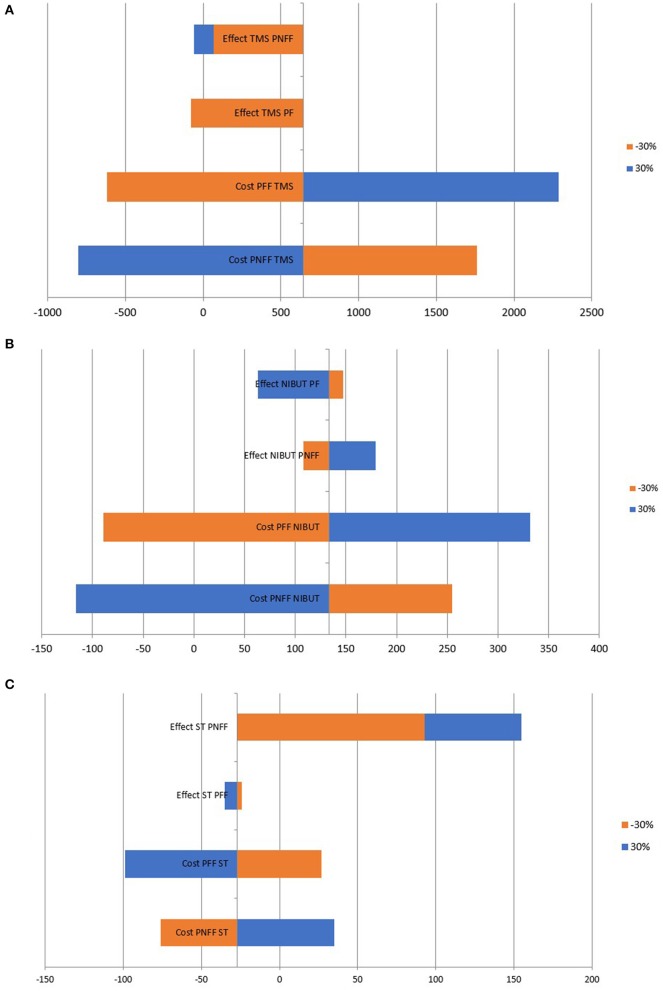
(A) TMS. (B) NIBUT. (C) ST.